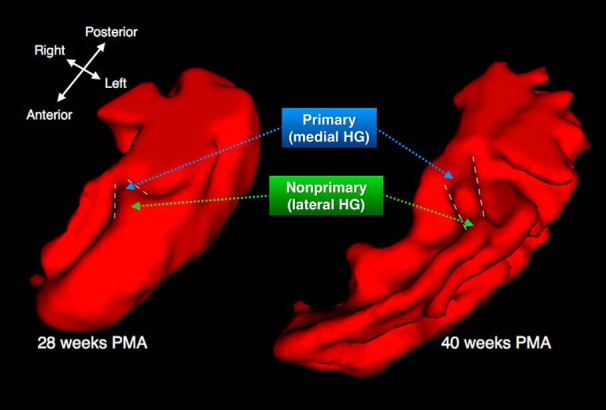
Development of the left hemisphere temporal plane from 28 to 40 weeks PMA. HG (demarcated with white dashed lines) is forming by 28 weeks PMA and has an adult-like appearance by 40 weeks PMA. pAC and nAC are located in medial and lateral HG, respectively.